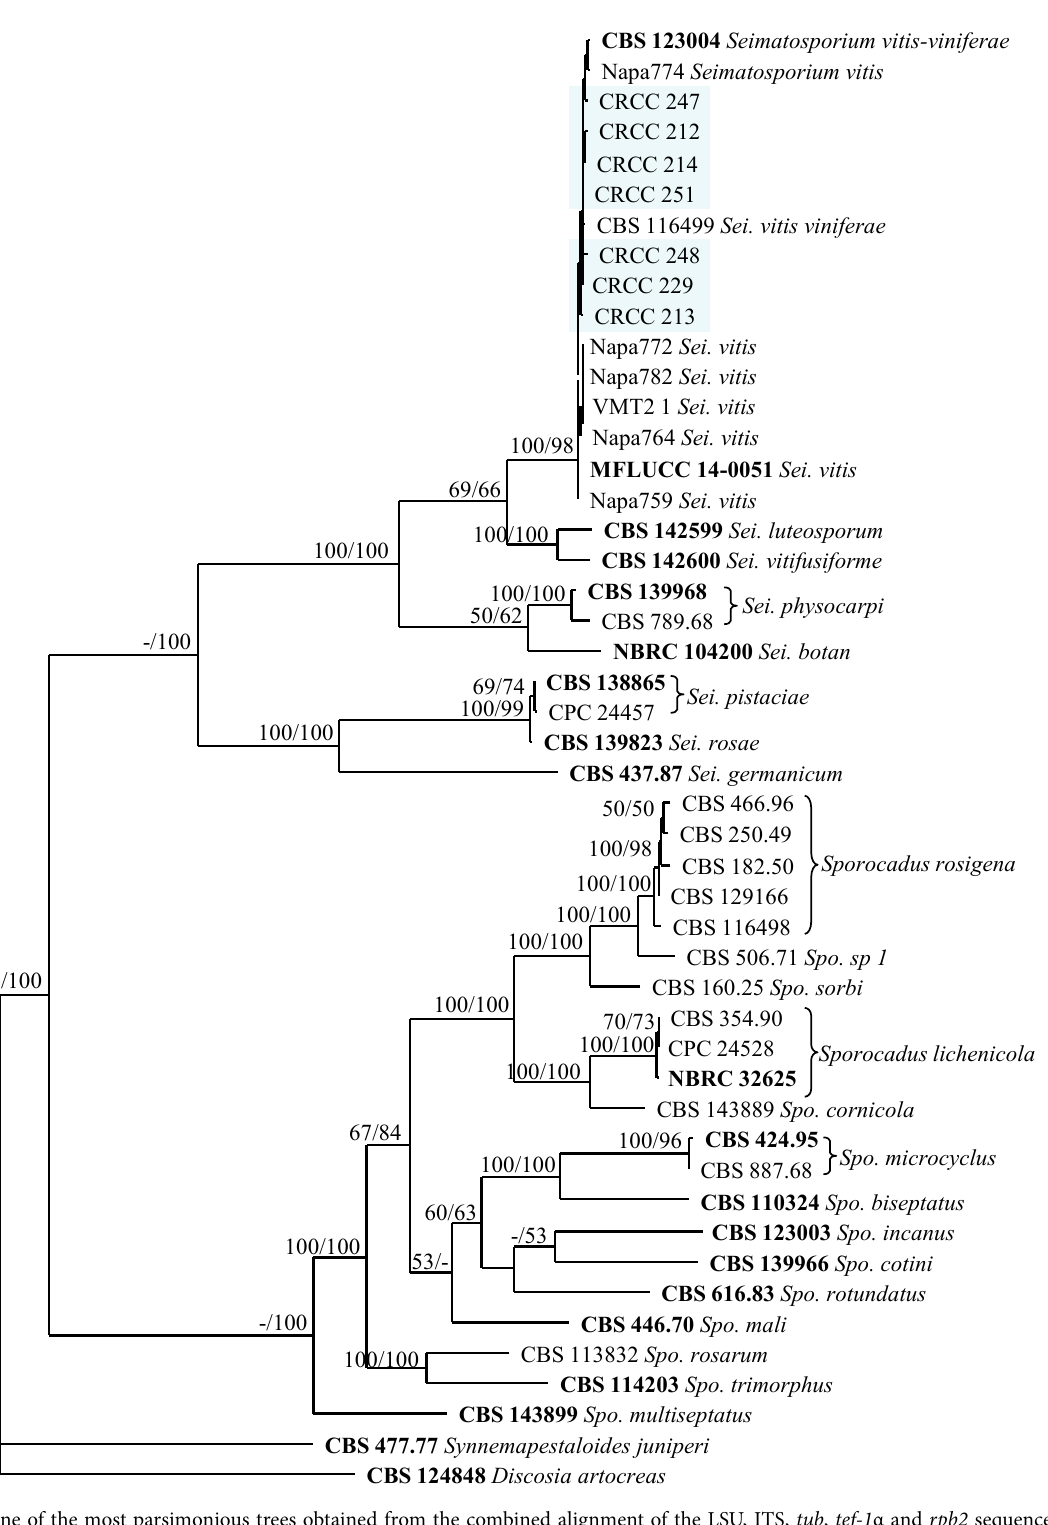
Figure 2. One of the most parsimonious trees obtained from the combined alignment of the LSU, ITS, tub , tef-1 α and rpb2 sequence data- sets of Seimatosporium isolates, with bootstrap support values from maximum parsimony/maximum likelihood analyses. Isolates obtained in this study are indicated by blue rectangles. Ex-type sequences are given in bold. Synnemapestaloides juniperi and Discosia artocreas were used as